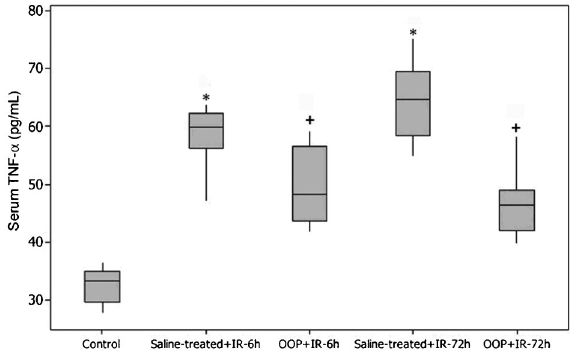
Figure 1. Serum tumor necrosis factor alpha (TNF- a ) levels of control, saline-treated++ionizing radiation (IR), or ozone oxidative preconditioning (OOP)++IR groups decapitated at 6 or 72 h after irradiation. Each group consisted of 8 rats. *P=0.001 compared to control group; + P=0.001 compared to saline-treated group (Mann-Whitney U-test).